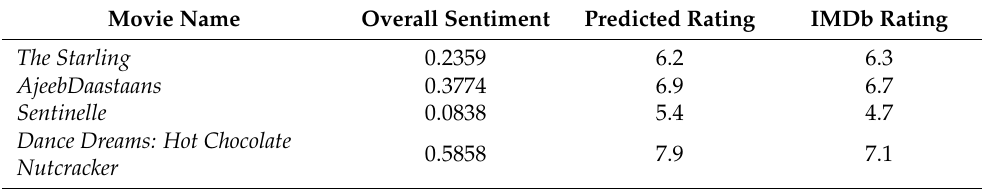
Table 5. Examples of some overall scores, predicted ratings, and IMDb ratings.